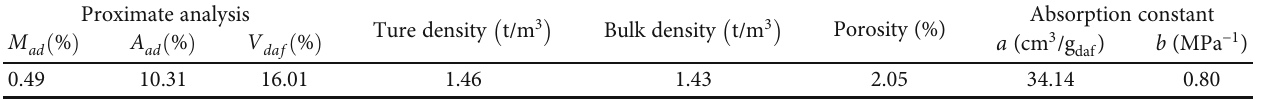
Table 1: Proximate analysis results and adsorption constants of coal samples. Proximate